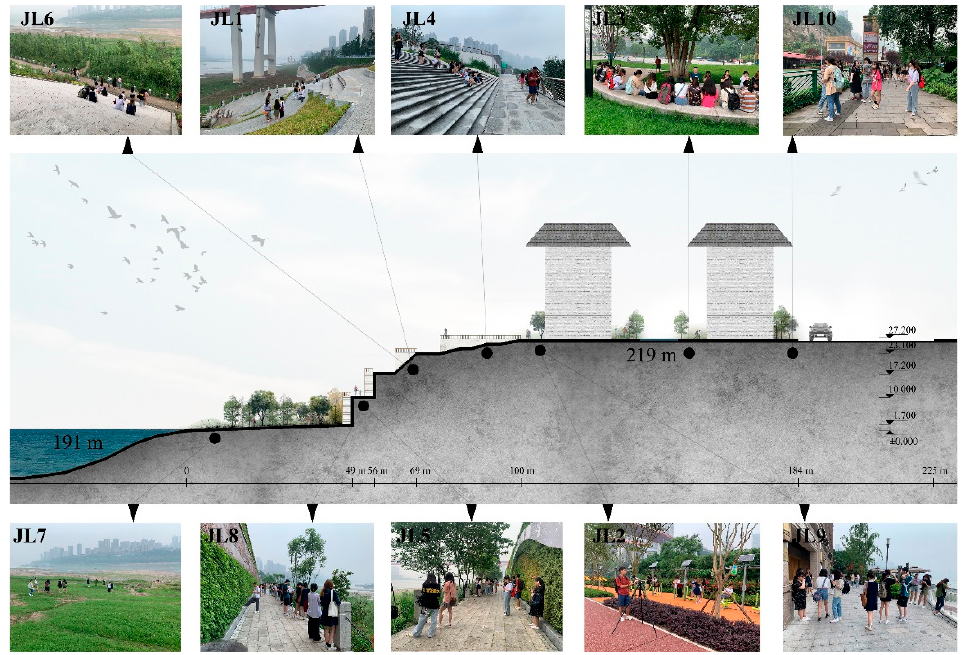
Figure 2. Sensewalking survey and mountainous topography status, taking JL as an example.